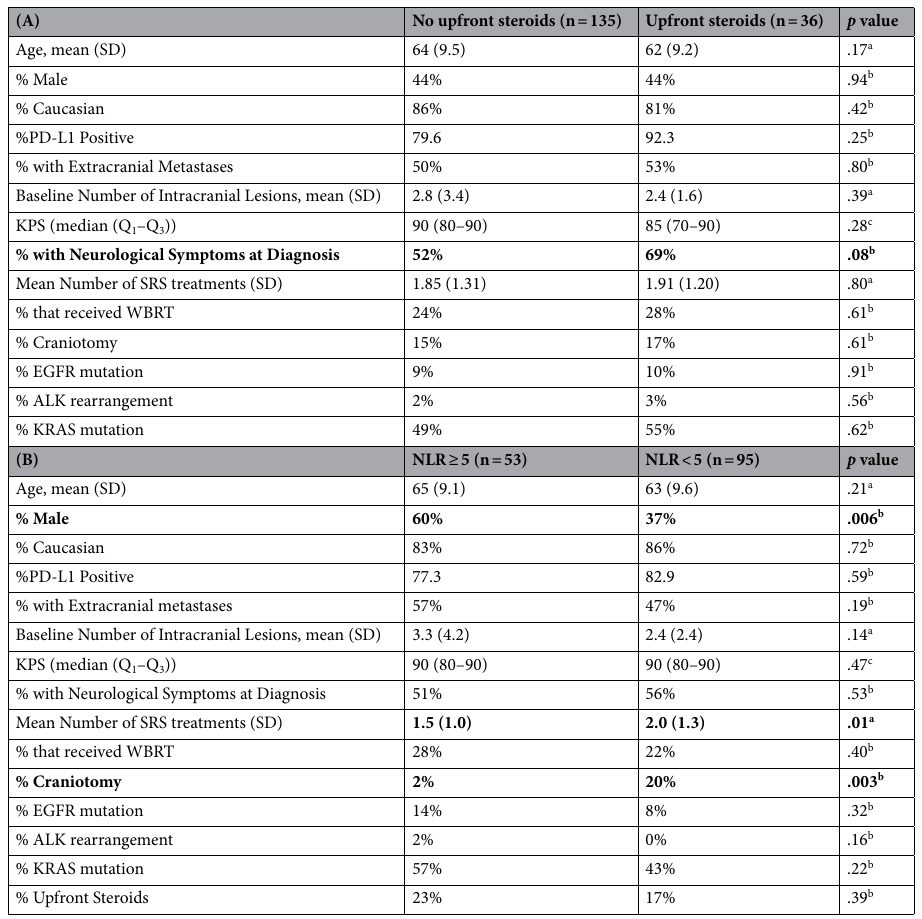
Table 1. Patient characteristics. (A) Patients separated into cohorts based upon upfront steroid usage within 30 days of start of immunotherapy. (B) Patients separated into cohorts based upon NLR status (≥ 5 vs. <